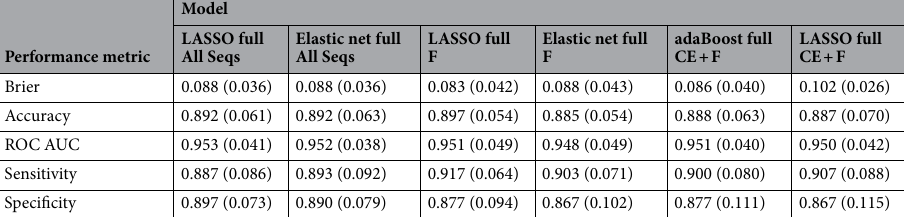
Performance metric